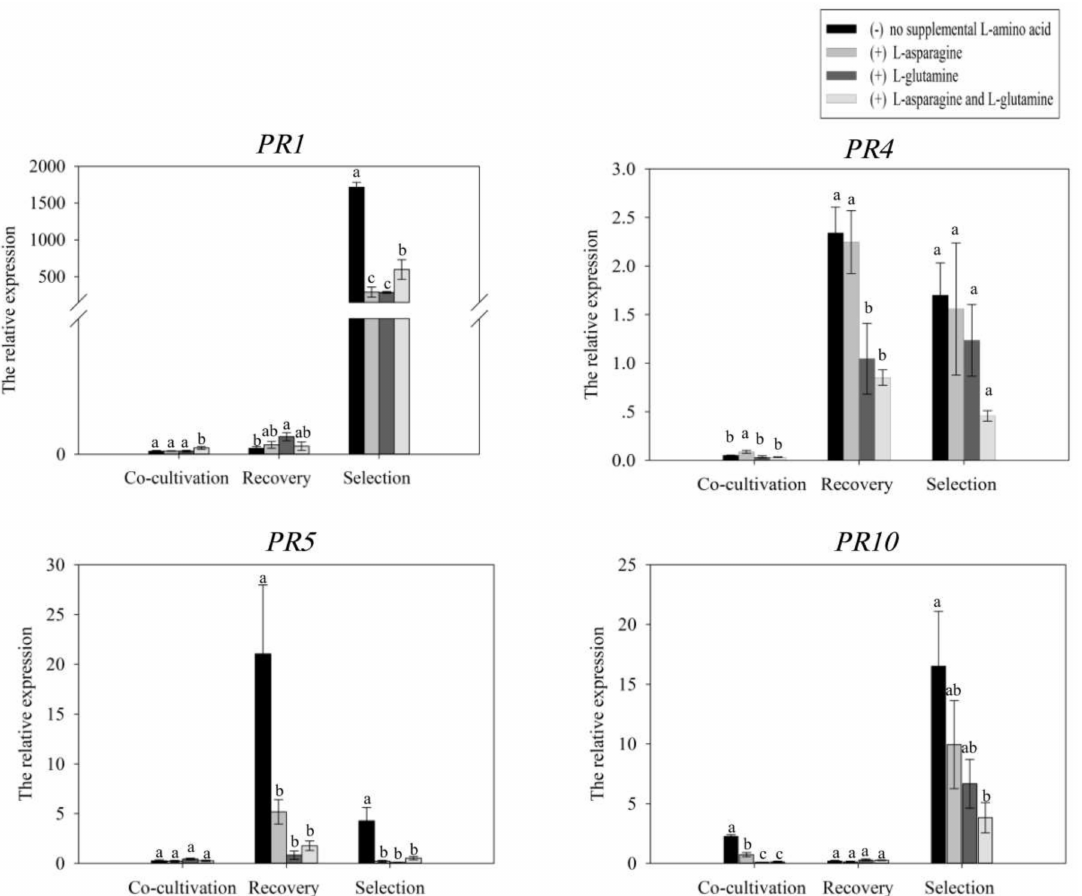
Figure 5. The expression level of GmPRs in different culture stage with treatments by qRT-PCR. The expression level of GmPR1 , GmPR4 , GmPR5 , and GmPR10 were analyzed during co-cultivation, recovery and selection culture. GmActin was used as an internal reference. The different small letters represent significant differences between treatments by ANOVA ( p <